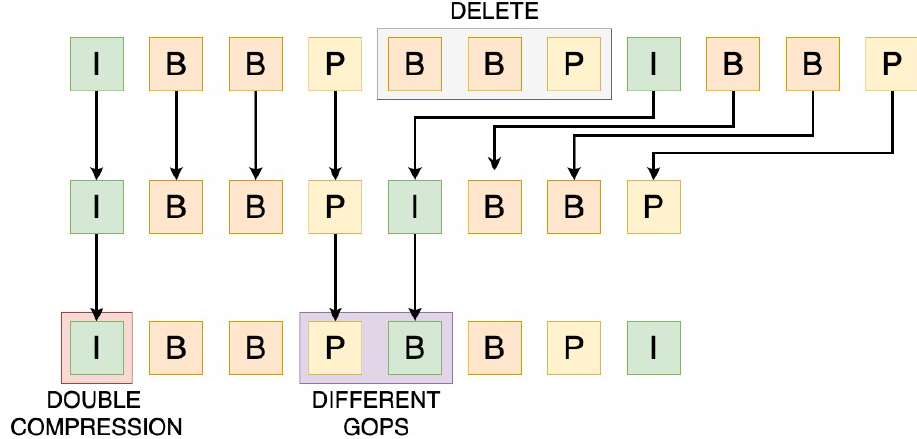
Figure 2. The top line shows an original MPEG encoded sequence. The next lines show the effect of deleting the three frames in the shaded area. The second line shows the reordered frames and the third line the recoded frames. The I-frame before erasing is subjected to double compression. Some of the frames following the deletion move from one GOP sequence to another. This double MPEG compression gives rise to specific statistical and temporal models that can be used to identify the platform of